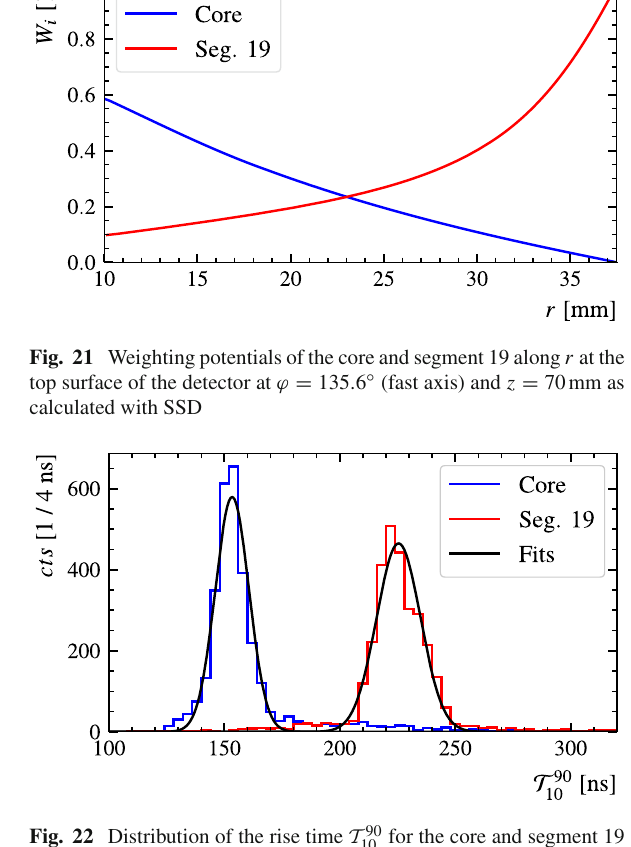
for the core and segment 19 10